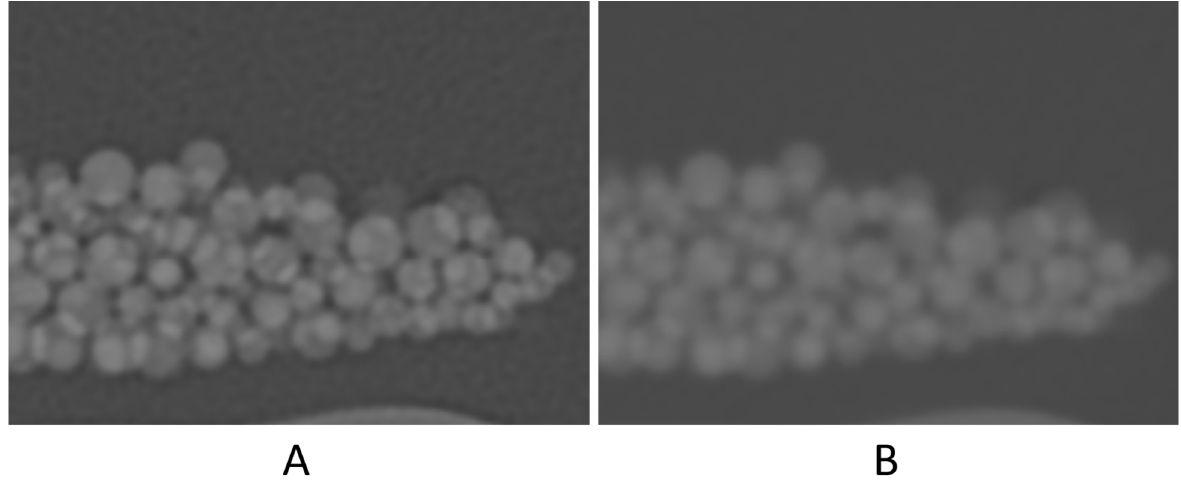
Figure 5. Zoomed-in images to compare the image appearance with Lung filter ( A ) and standard filter ( B ).